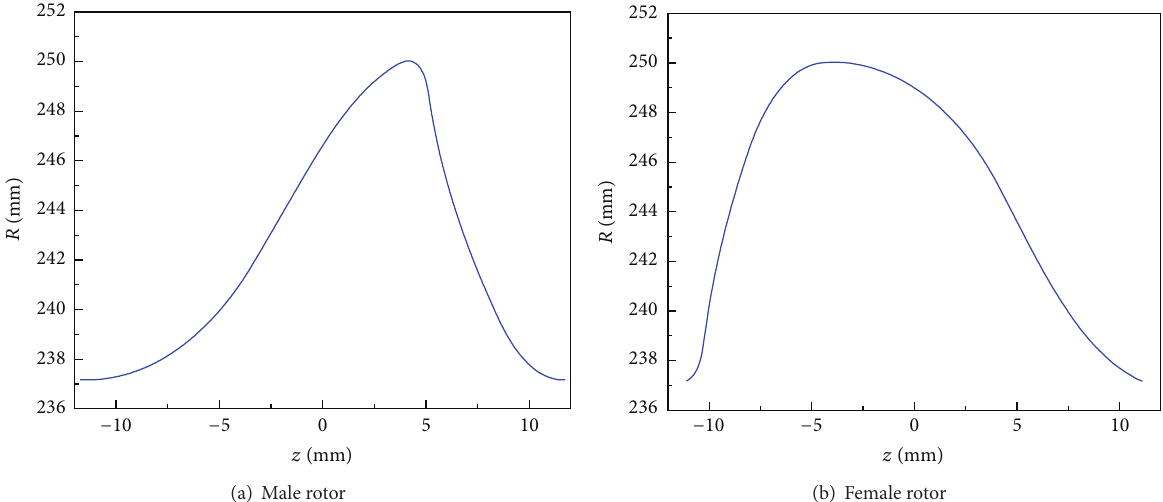
Figure 5: Forming tool profile of rotors.